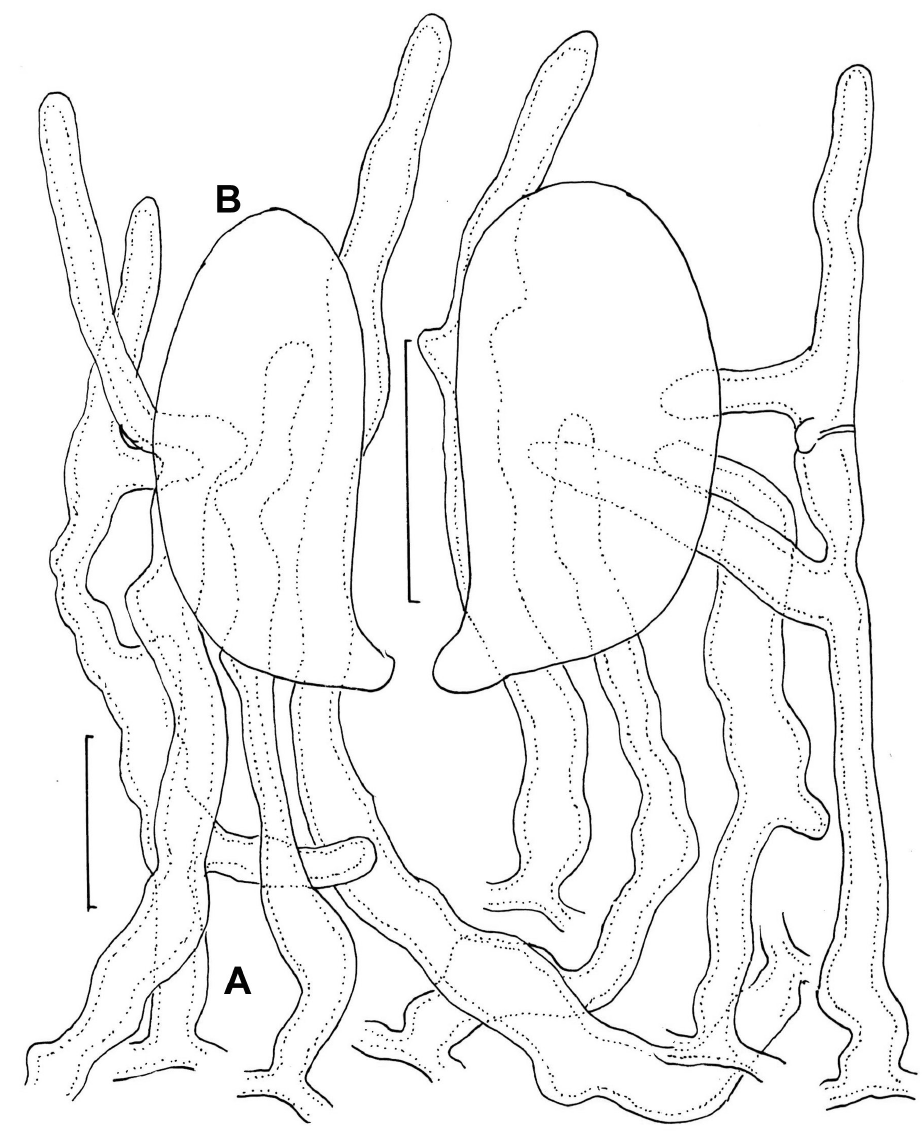
Figure 63. Mycetinis prasiosmus . A Caulocystidia B Basidiospores. Standard bars: A = 10 µm; B = 5 µm. FES 1155